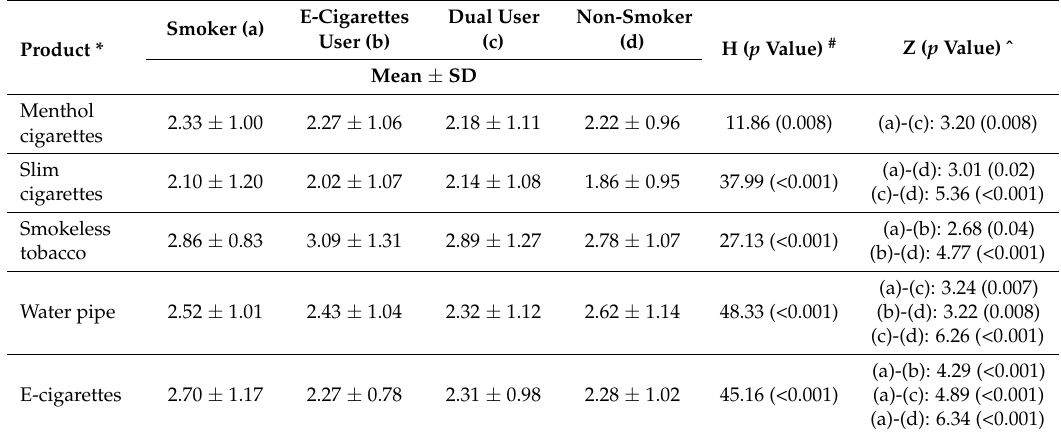
Table 2. Mean scores for the perceived harmfulness of the selected tobacco/nicotine products by a participant’s traditional cigarette/e-cigarette use